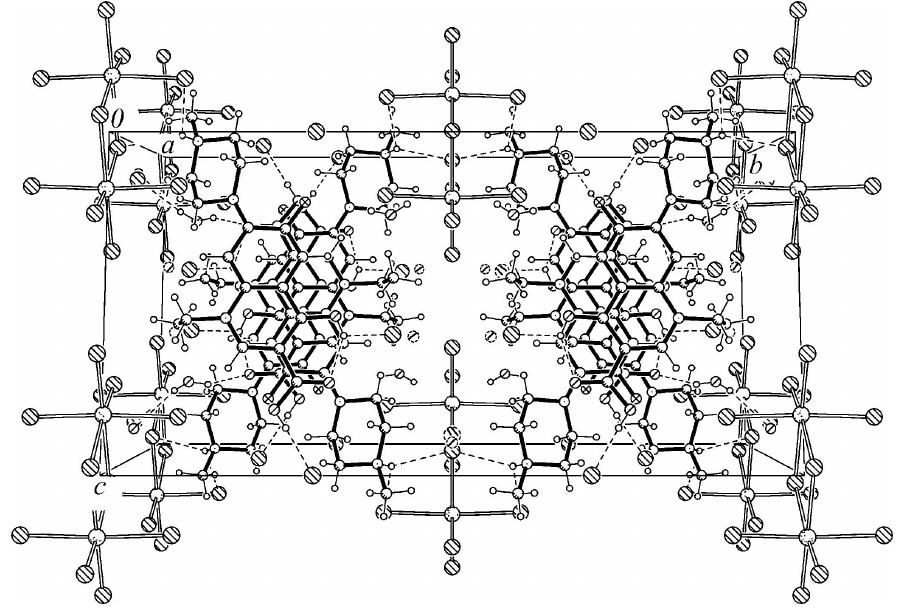
Figure 3 2+ canion, with displacement ellipsoids drawn at the 50% probability level. The intramolecular A view of the pfH 3 hydrogen bond is shown as a dashed line.